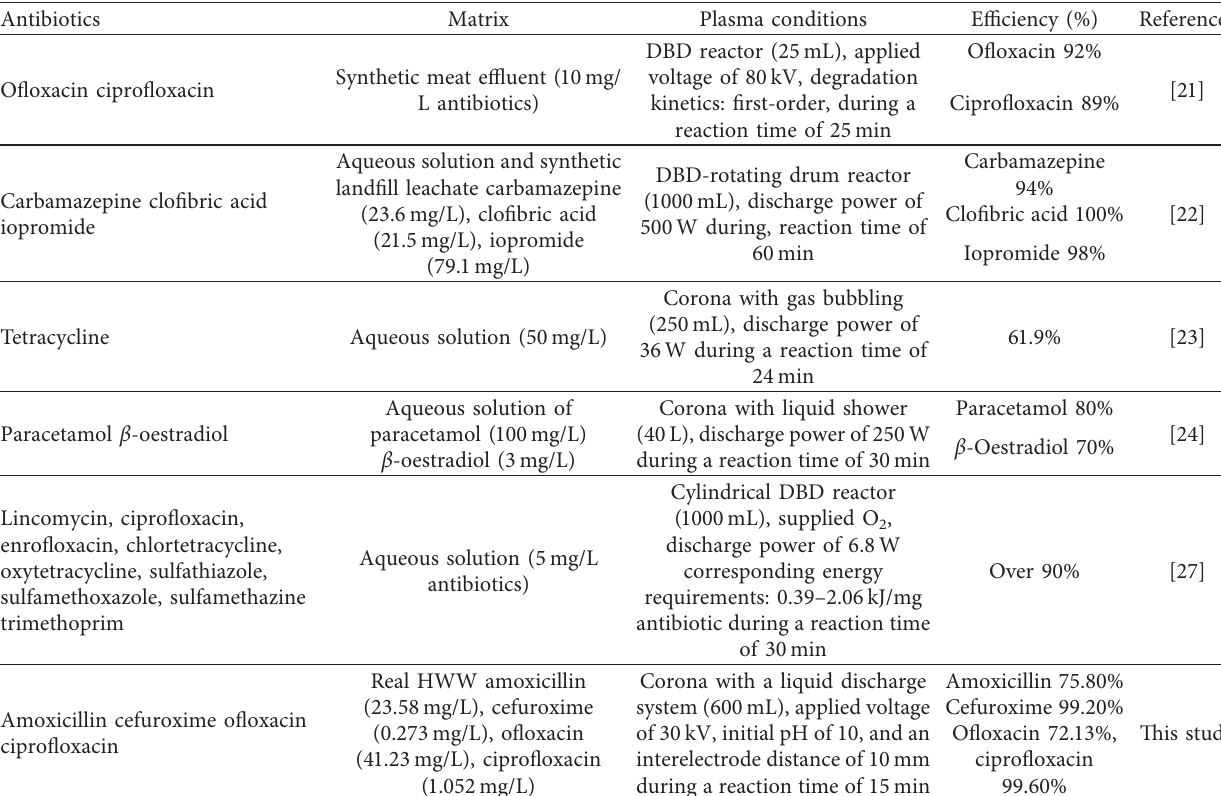
Table 2: Some recent findings of cold plasma treatment for the elimination of antibiotic compounds in water or wastewater.